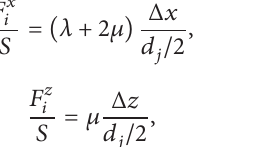
oscillators connected in a series with a mass from 𝑚 1 to 𝑚 𝑛